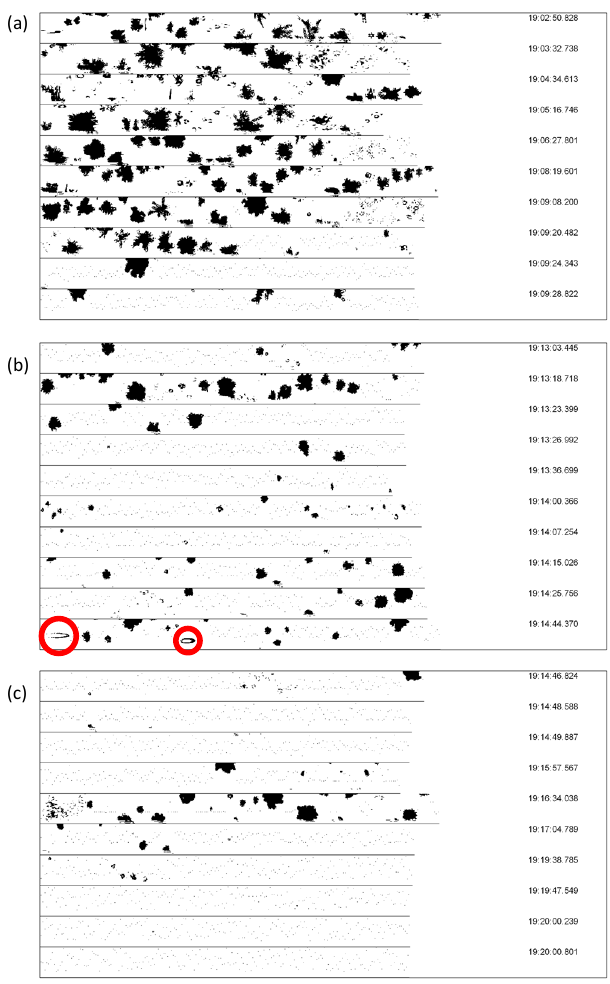
Fig. 6. (a–c) 2-D CIP images recorded on flight #104 between 19:02:50 to 19:20:00 during the ascent through orographic cloud over the Antarctic Peninsula. The timestamps correspond to the im- ages at the righthand side of each strip. These are the raw images, before ice shattering artefacts have been removed. The particles highlighted with red circles are speculated to be raindrops.